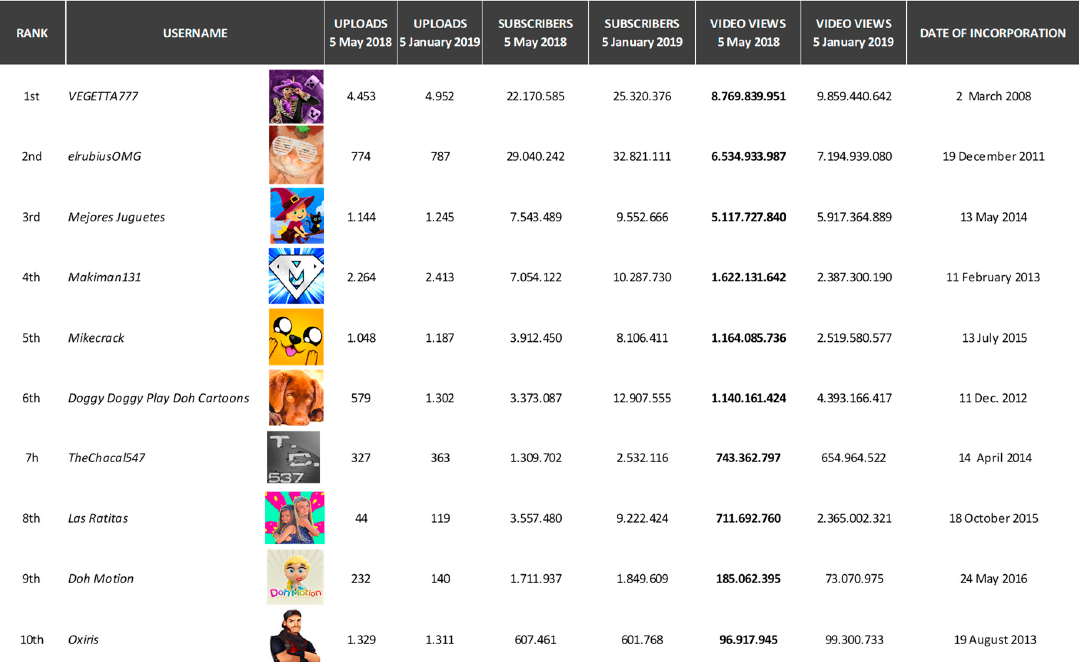
Figure 10. Social Blade ranking of 10 top Spanish YouTubers in descending order: SB Rank, video views, and subscribers.